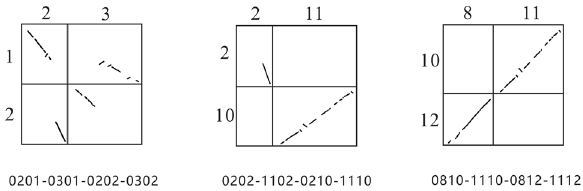
Figure 4. Search results for chromosome rearrangement patterns in the Gossypium raimondii and Gossypium arboreum genomes.